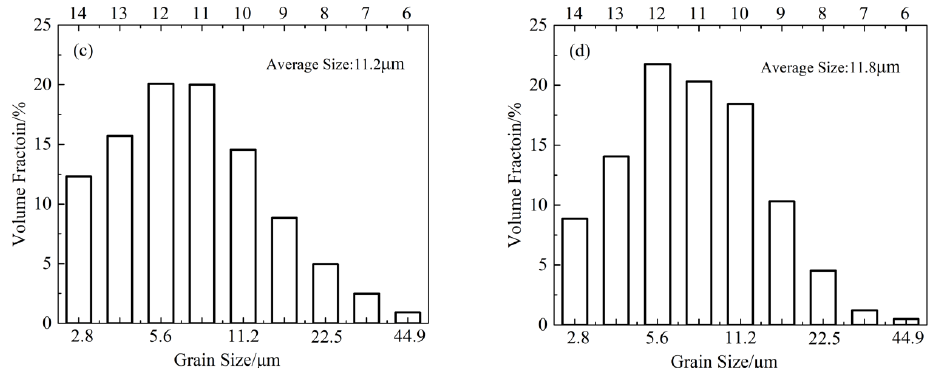
Figure 2. Grain size distribution at different annealing temperatures. ( a ) 710 °C, ( b ) 730 °C, ( c ) 760 °C and ( d ) 780 °C.